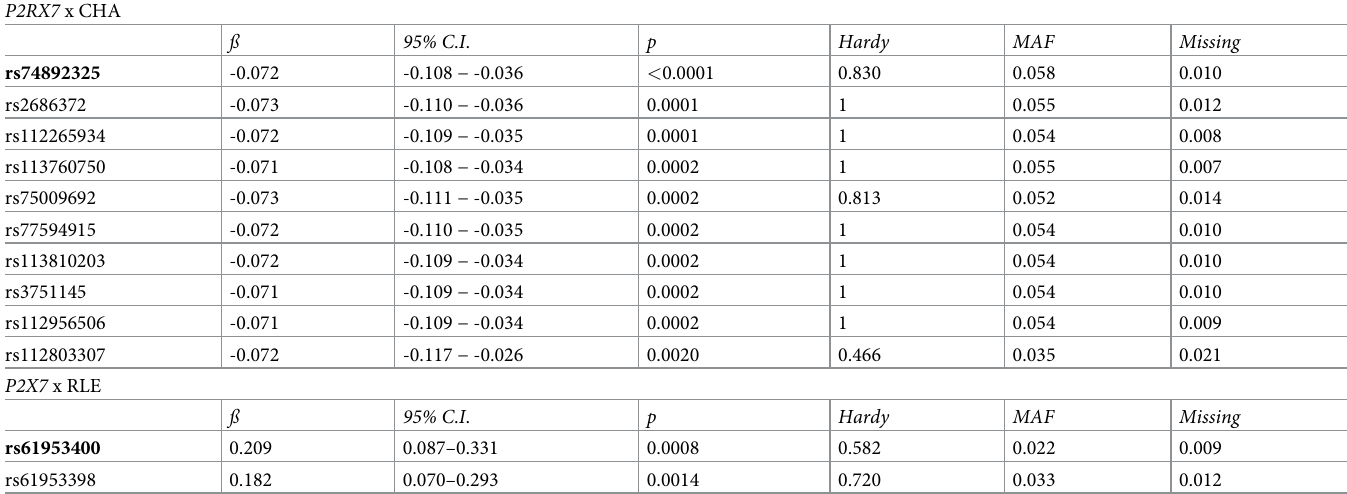
Table 2. Significant clumps of P2RX7 SNPs interacting with early childhood adversities (CHA) and recent life events (RLE) on current depression symptoms. P2RX7 x CHA